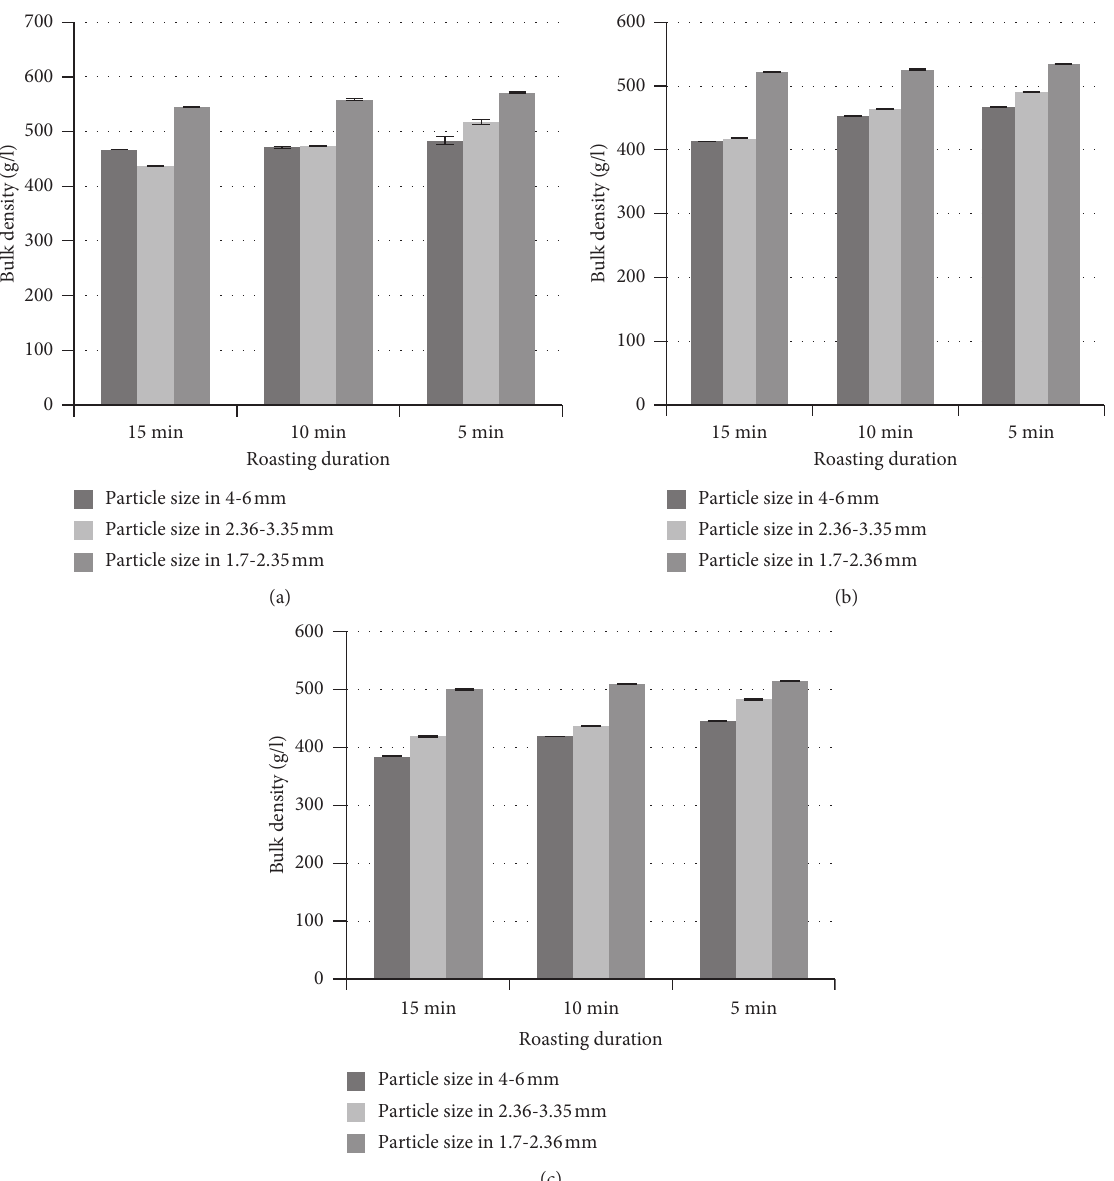
Figure 3: Effect of coffee bean particle size, roasting temperature, and time on the bulk density of the coffee bean. (a) Roasting temperature at 200 ° C. (b) Roasting temperature at 230 ° C. (c) Roasting temperature at 260 °